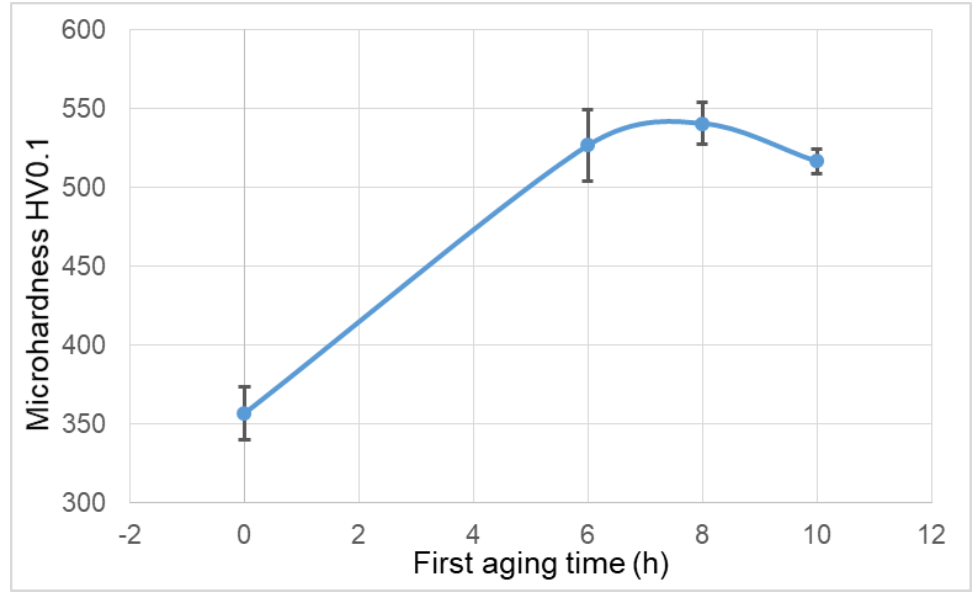
Figure 11. Results of the Vickers hardness measurements.